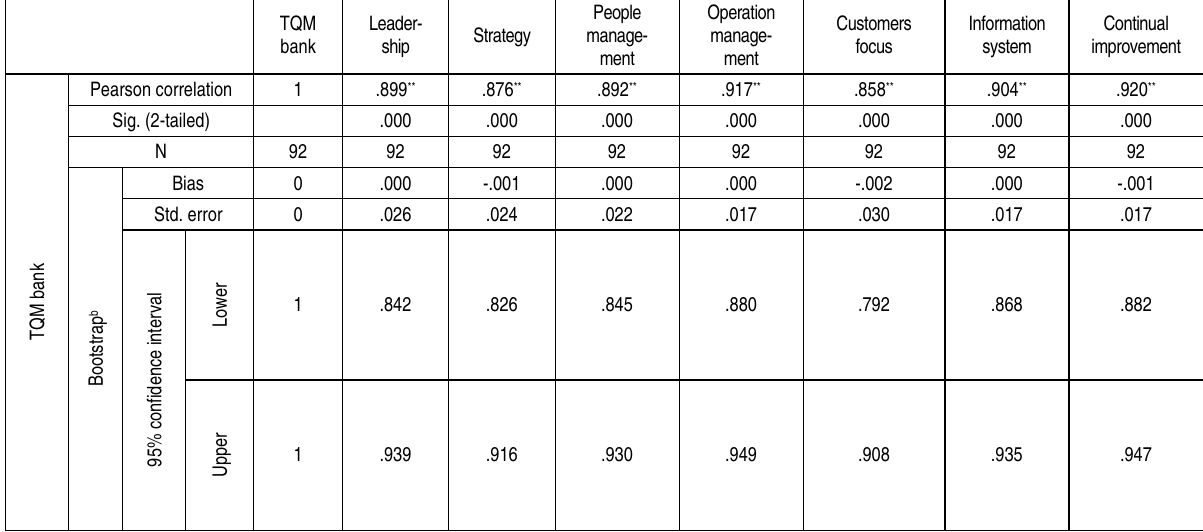
Table 3. Pearson correlations coefficients